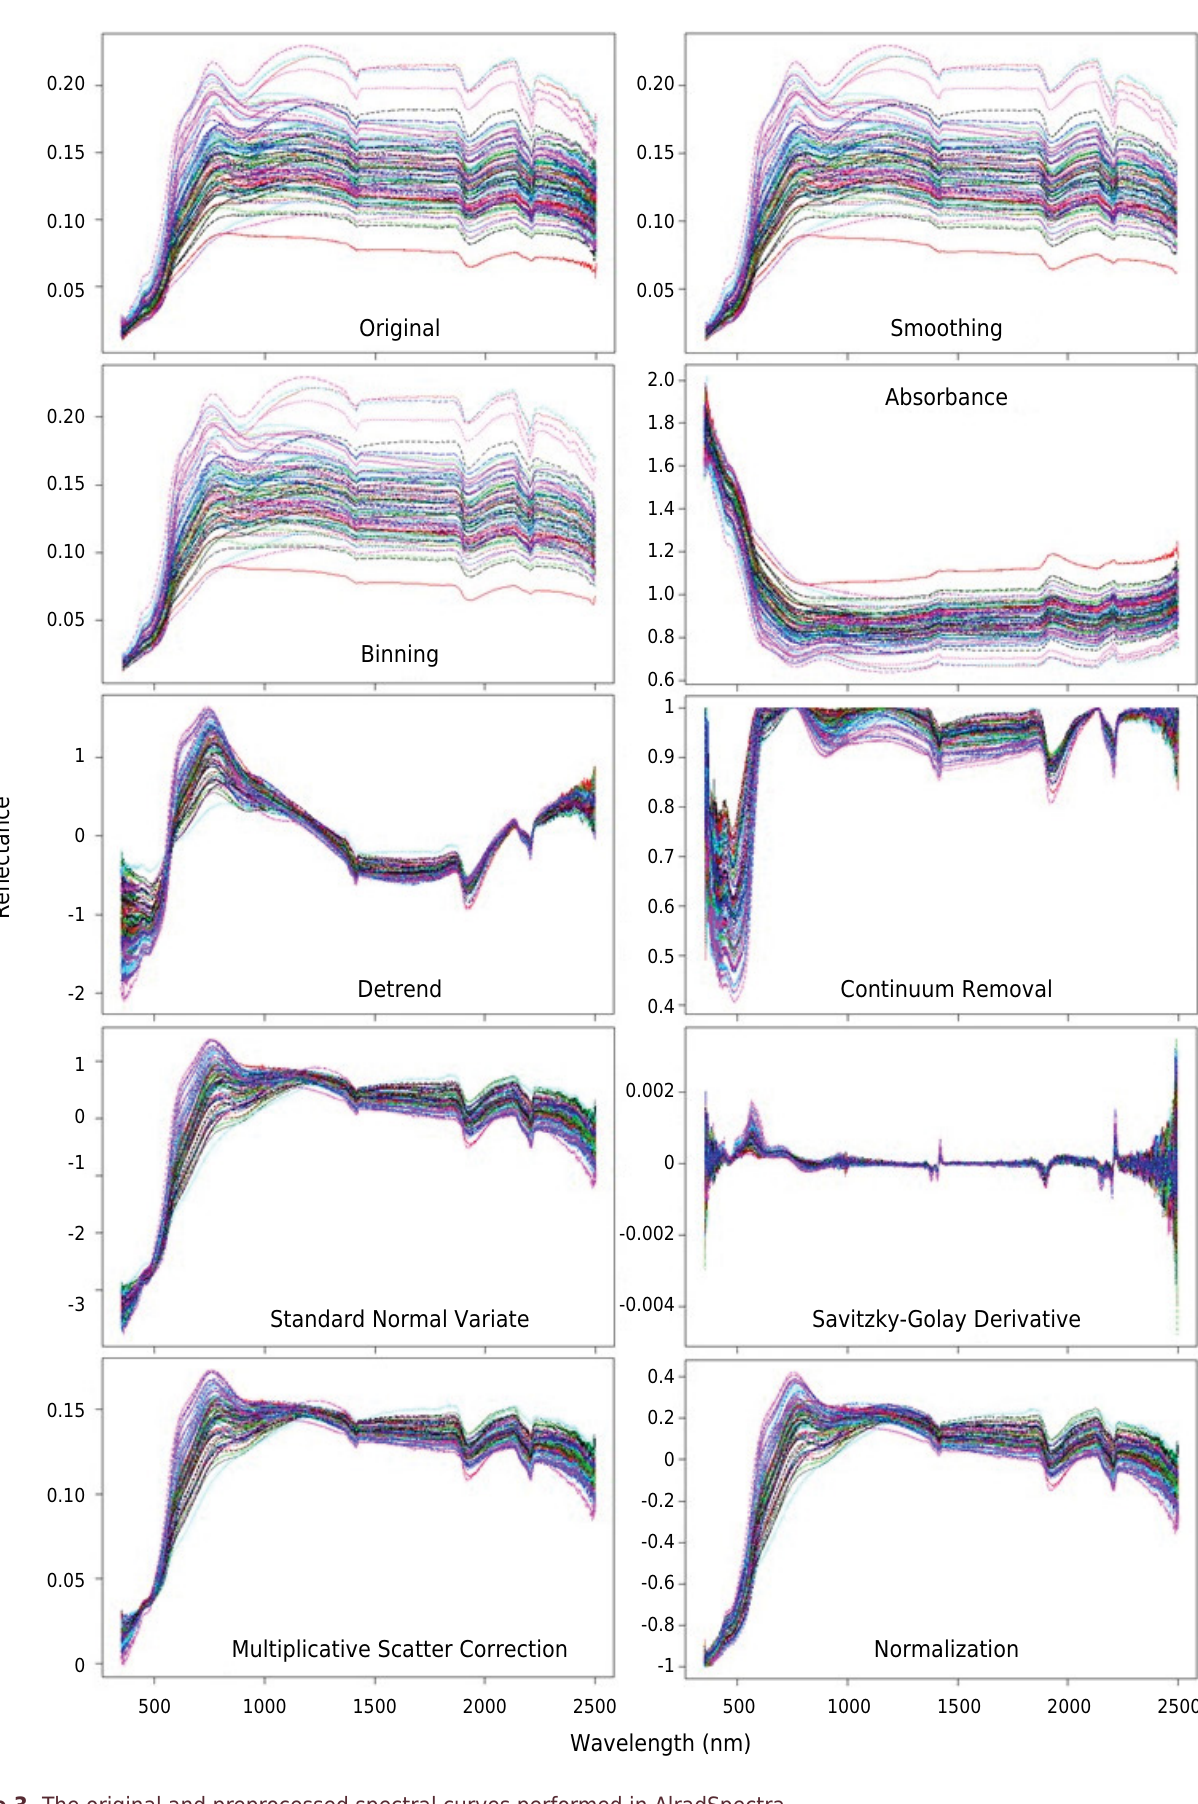
Figure 3. The original and preprocessed spectral curves performed in